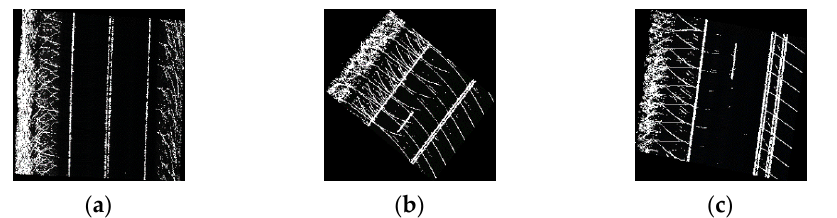
Figure 11. Lane marking misdetection by the pre-trained U-net model for the target domain da- tasets: ( a ) one-lane highways with dual lane marking at the center, ( b ) dual lane markings at the edge, and ( c ) pair of dual lane markings at the edge.